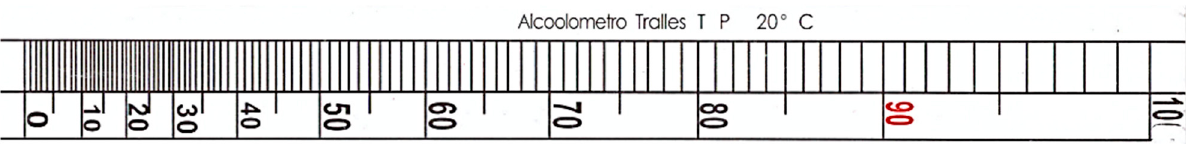
Figure 6. Flattened scale of one sample of commercially available alcoholmeter with obvious non- linear distribution of the graduations. linear distribution of the